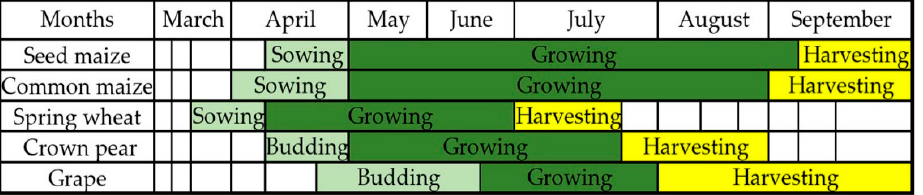
Figure 7. The phenological calendar of the main crops in the study area.